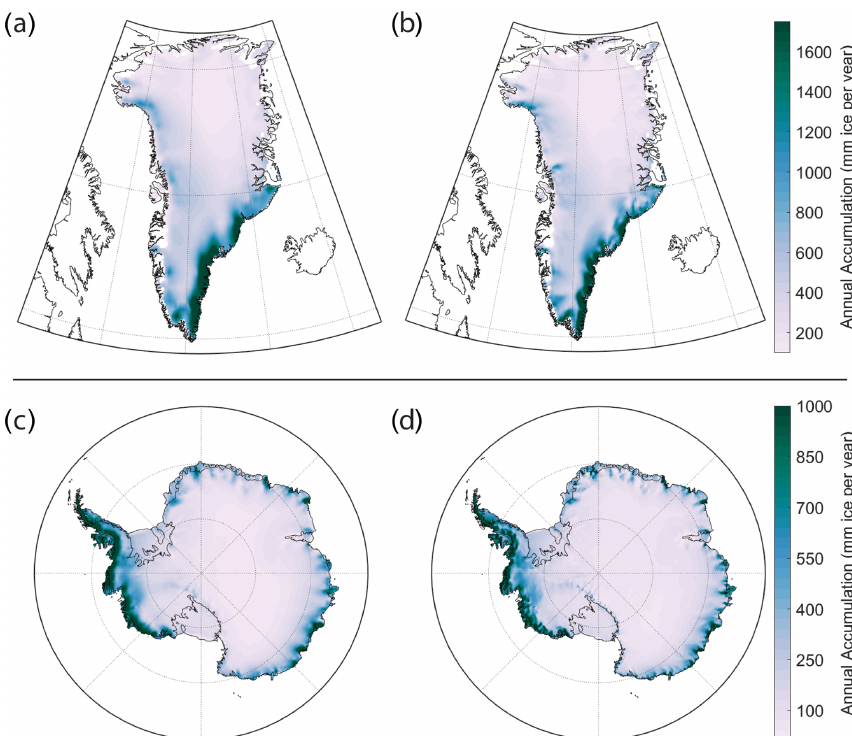
Figure 5. Mean annual net accumulation (snowfall minus sublimation) for the Greenland (a, b) and Antarctic (c, d) ice sheets from MERRA- 2 (a, c) and M2R12K (b, d) over their contemporaneous time span (2000–2014). Note the differences in color scale for Greenland and